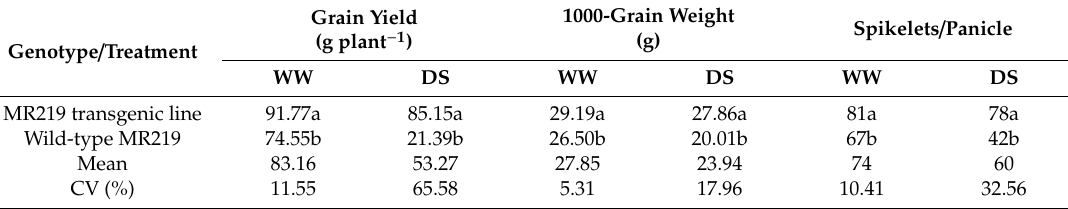
Table 7. The grain yield, 1000-grain weight, and spikelets / panicle of the rice genotypes under well-watered (WW) and drought stress (DS)